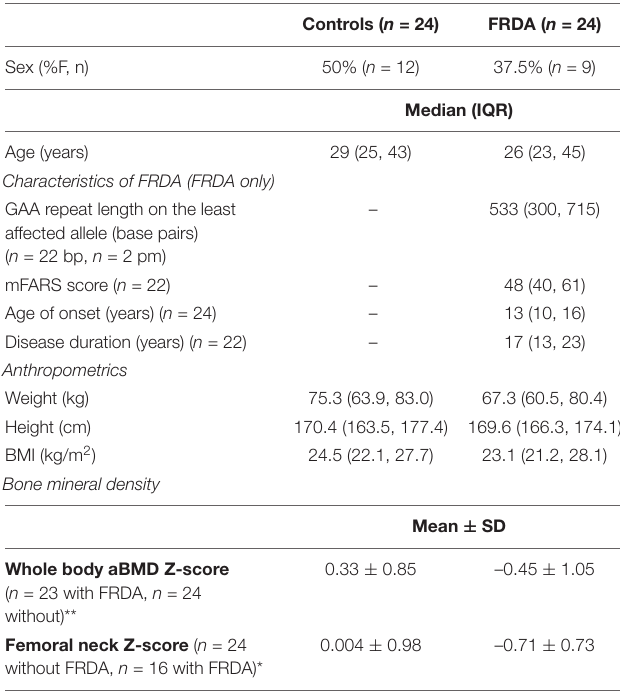
Demographic and anthropometric data, characteristics of FRDA (FRDA only), and skeletal site specific aBMD for healthy adult controls and adults with FRDA. Age and anthropometric data were collected at the time of the DXA scan. Skeletal site specific aBMD is expressed as a Z-score. Time varying FRDA characteristics (mFARS score and disease duration) were obtained at the closest FACOMS visit within 6 months from the DXA scan; the time varying characteristics of FRDA (mFARS scores, and disease duration) were not recorded for individuals without a recent FACOMS visit. Values in bold text indicate a statistically significant